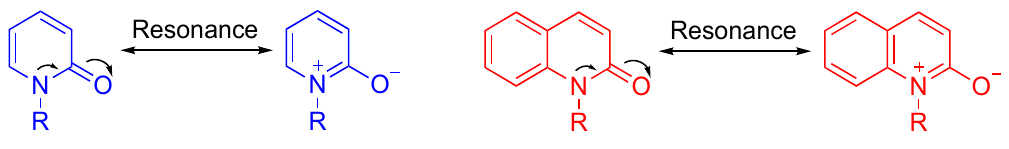
Figure 3. Resonance structure of pyridone framework.